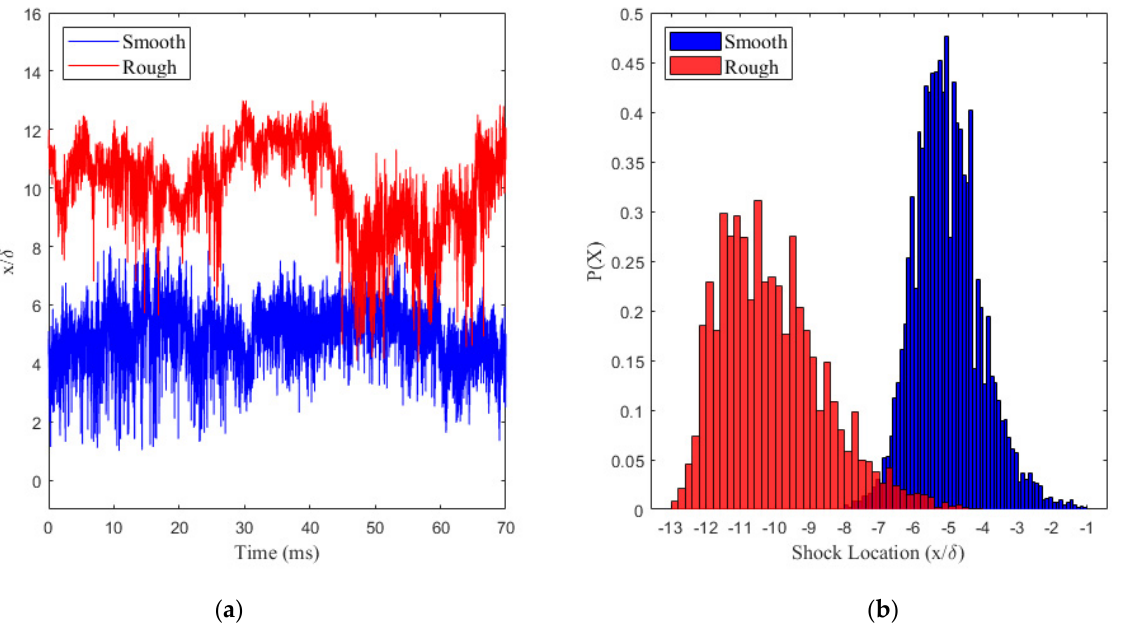
Figure 7. ( a ) Normalized shock foot location time series, and ( b ) histogram normalized as a PDF of smooth and rough SWBLI mean shock foot location. Table 3. Summary of shock-motion using descriptive statistics.